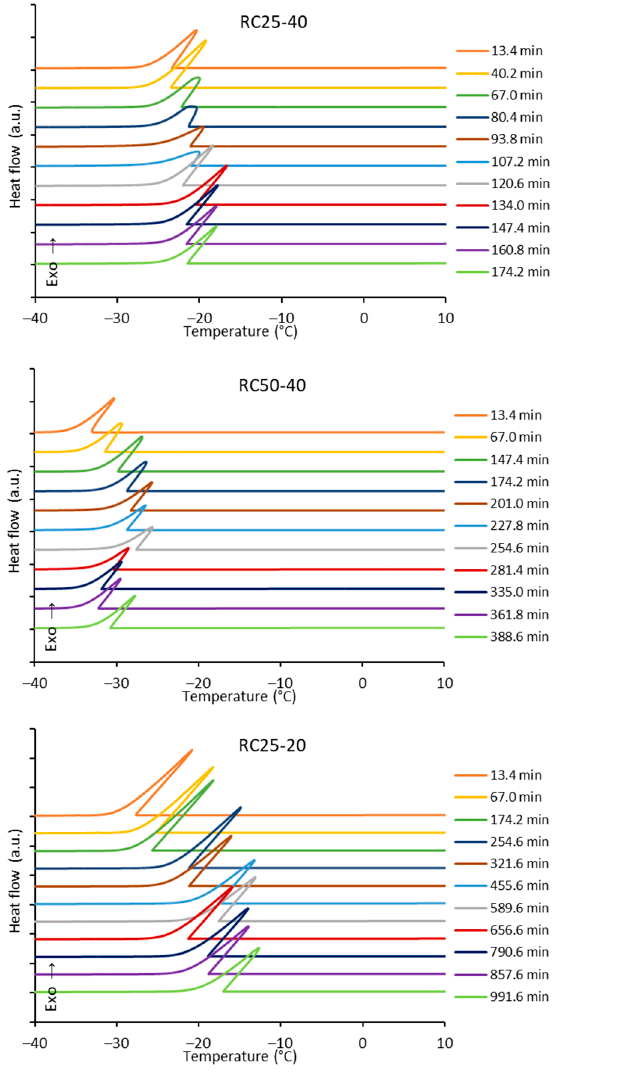
Figure 6. Development of the freezing ( left ) and melting ( right ) curves of reaction mixtures over time. The scale marks on heat flow axes represent 5 W/g for freezing and 1 W/g for melting curves.